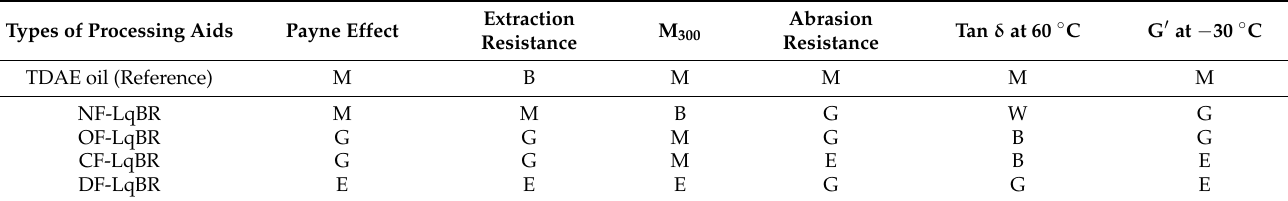
Table 11. Effect of the functional group position of F-LqBR on the performance of silica-filled rubber compounds. Types of Processing